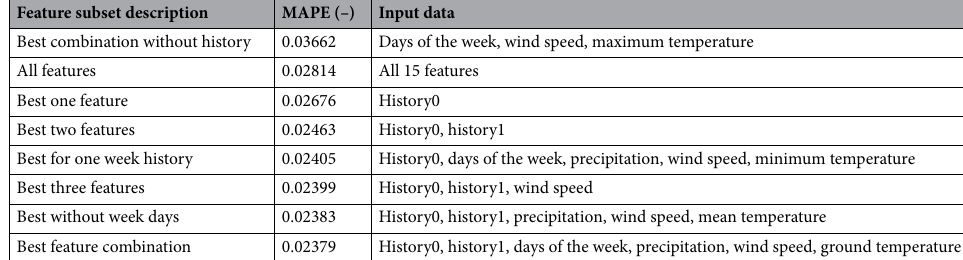
Table 2. Mean absolute percentage error for linear regression and selected input